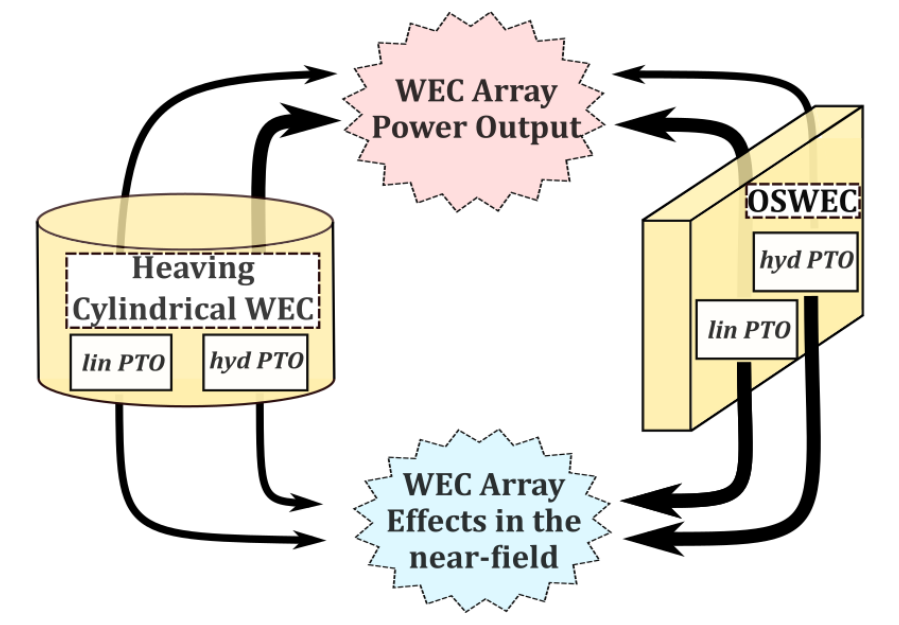
Figure 23. Schematic diagram showing the relationship between the PTO system impacts of the two types of WECs in an array. Thick arrows represent strong influences on the indicated parameters while thin arrows represent weak